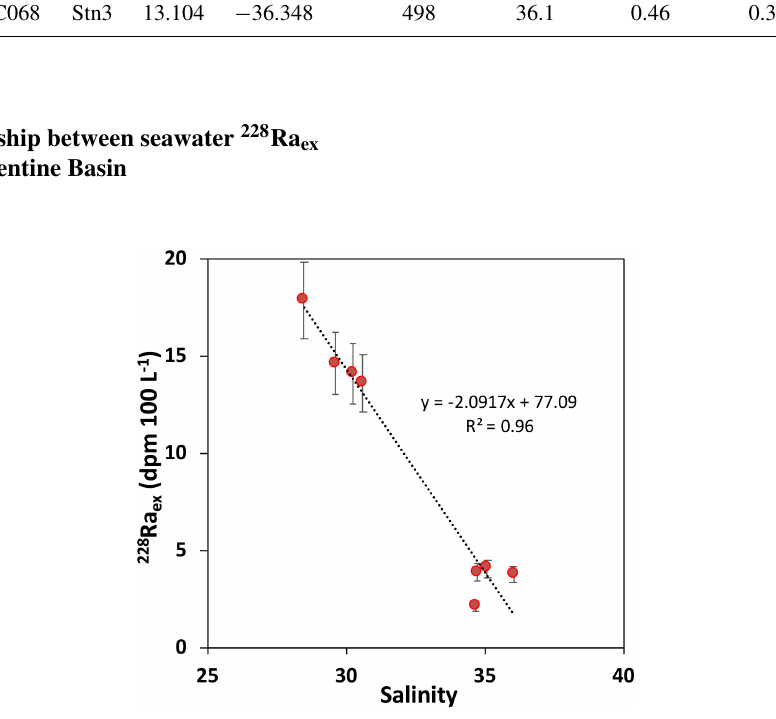
Figure C1. Relationship between seawater 228 Ra ex activity and salinity in the Argentine Basin. The dashed line shows the linear regression. The error bars of 228 Ra ex activity are 2